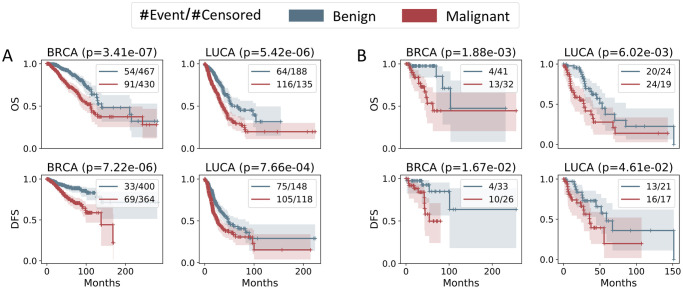
Kaplan-Meier estimators of predicted malignant and benign cohorts using both clinical and genomic features.(A) TCGA, (B) ICGC. Logrank test shows significant distinct survival and recurrence profiles between the two cohorts across both datasets and cancer types.